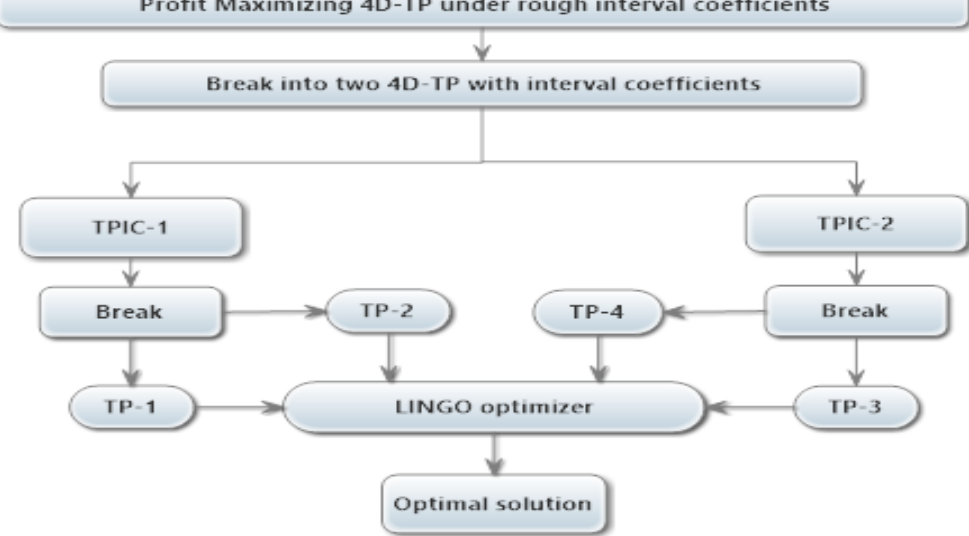
Figure 2. Optimization flowchart of 4D-TP under rough interval